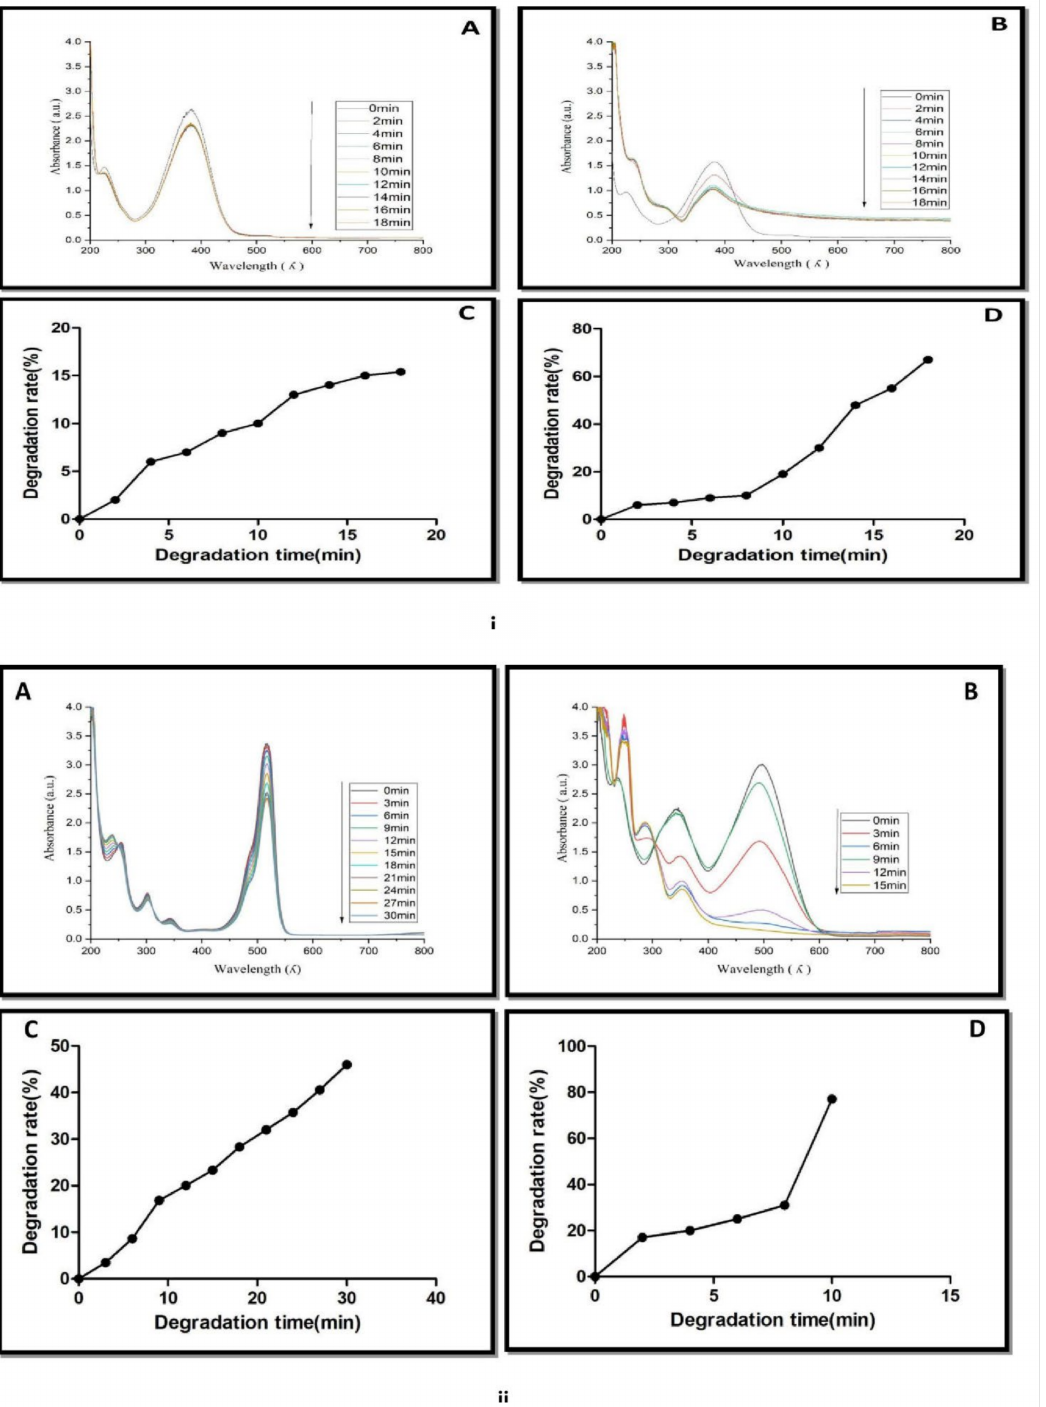
Figure 10. ( i ) UV-Vis spectra of 4-nitroaniline reduction in presence of ( A ) NaBH 4 , ( B ) NaBH 4 + green biosynthesized AgNPs, ( C ) Catalytic degradation (%) with NaBH 4 . ( D )Catalytic degradation (%) with NaBH 4 + AgNPs. ( ii ) UV-Vis spectra of congo red reduction in presence of ( A ) NaBH 4 and ( B ) NaBH 4 + green biosynthesized AgNPs. ( C ) Catalytic degradation (%) with NaBH 4 . ( D ) Catalytic degradation (%) with NaBH 4 +